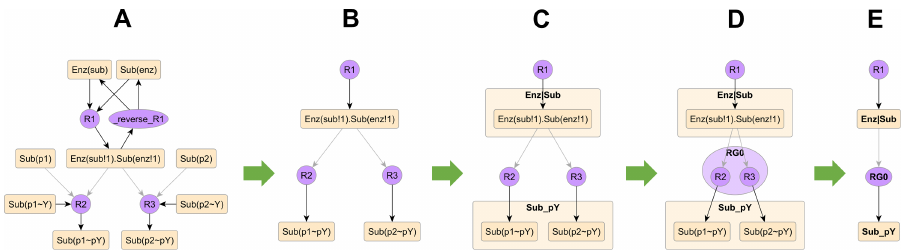
Fig 4. Compressing AR graphs. (A) The full model AR graph from Fig 3C. (B) Removing atoms and rules with low priority, such as free bindingsites, unphosphorylated states and the unbindingrule. (C) Grouping structurally similar atoms, e.g., Sub_pY= phosphorylated states of p1 and p2 , Enz|Sub = bond linkingEnz and Sub. (D) Grouping rules with similar edge signatures, e.g., rules R2 and R3 both have a context edge from Enz|Sub and a product edge into Sub_pY. (E) Each group is mergedinto a single node that combinesall incidentedges. PanelsB-C are semi-automated, whereaspanels D-E are fully automated.